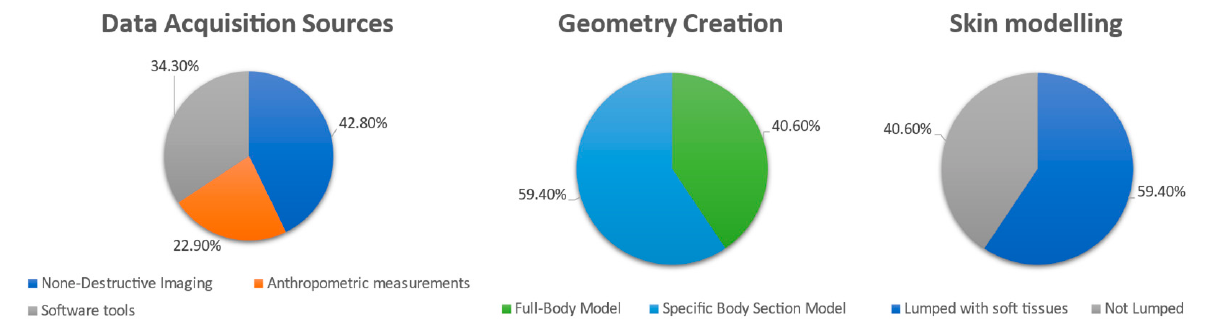
Figure 5. Pie Charts showing the percentage of methods used to acquire data for model generation ( left ), type of geometry created ( middle ), and skin modeling methodology ( right ).